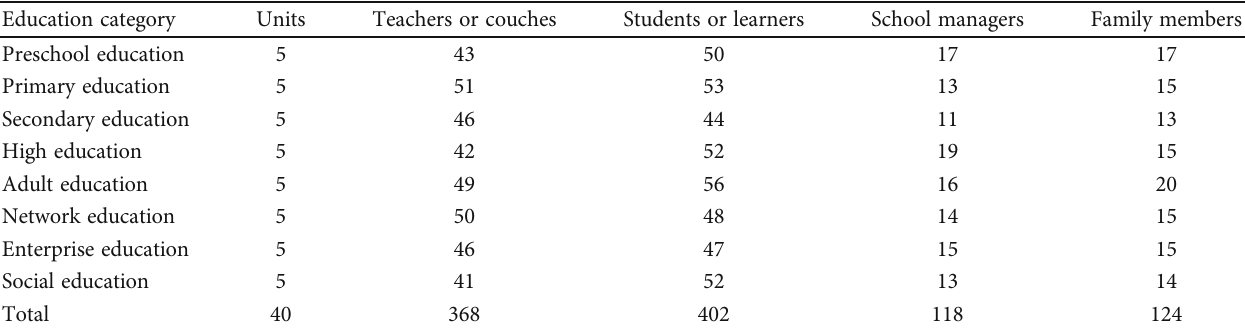
Table 2: Sampling distribution of each education category in each education system of Taiyuan